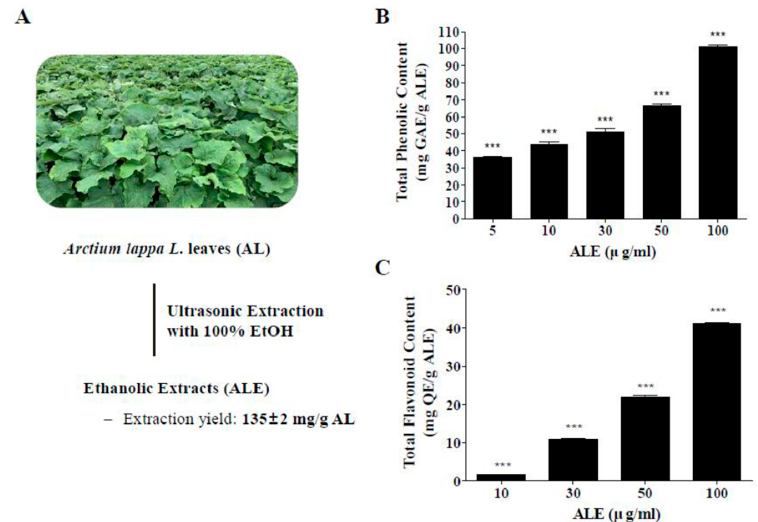
Figure 1. Extraction of AL and total polyphenol contents in extract of AL leaves (ALE). ( A ) Ethanolic extracts and extraction yield of ALE. ( B ) TPCs in ALE in a dose range from 5 to 100 μ g/mL. ( C ) TFCs in ALE in a dose range from 10 to 100 μ g/mL. The values represent the mean ± SD ( n ≥ 3). *** p < 0.001 vs blank group, one-way ANOVA with Tukey’s post hoc test. TPC, total phenolic content; TFC, total flavonoid content; GAE, gallic acid equivalent; QE, quercetin.